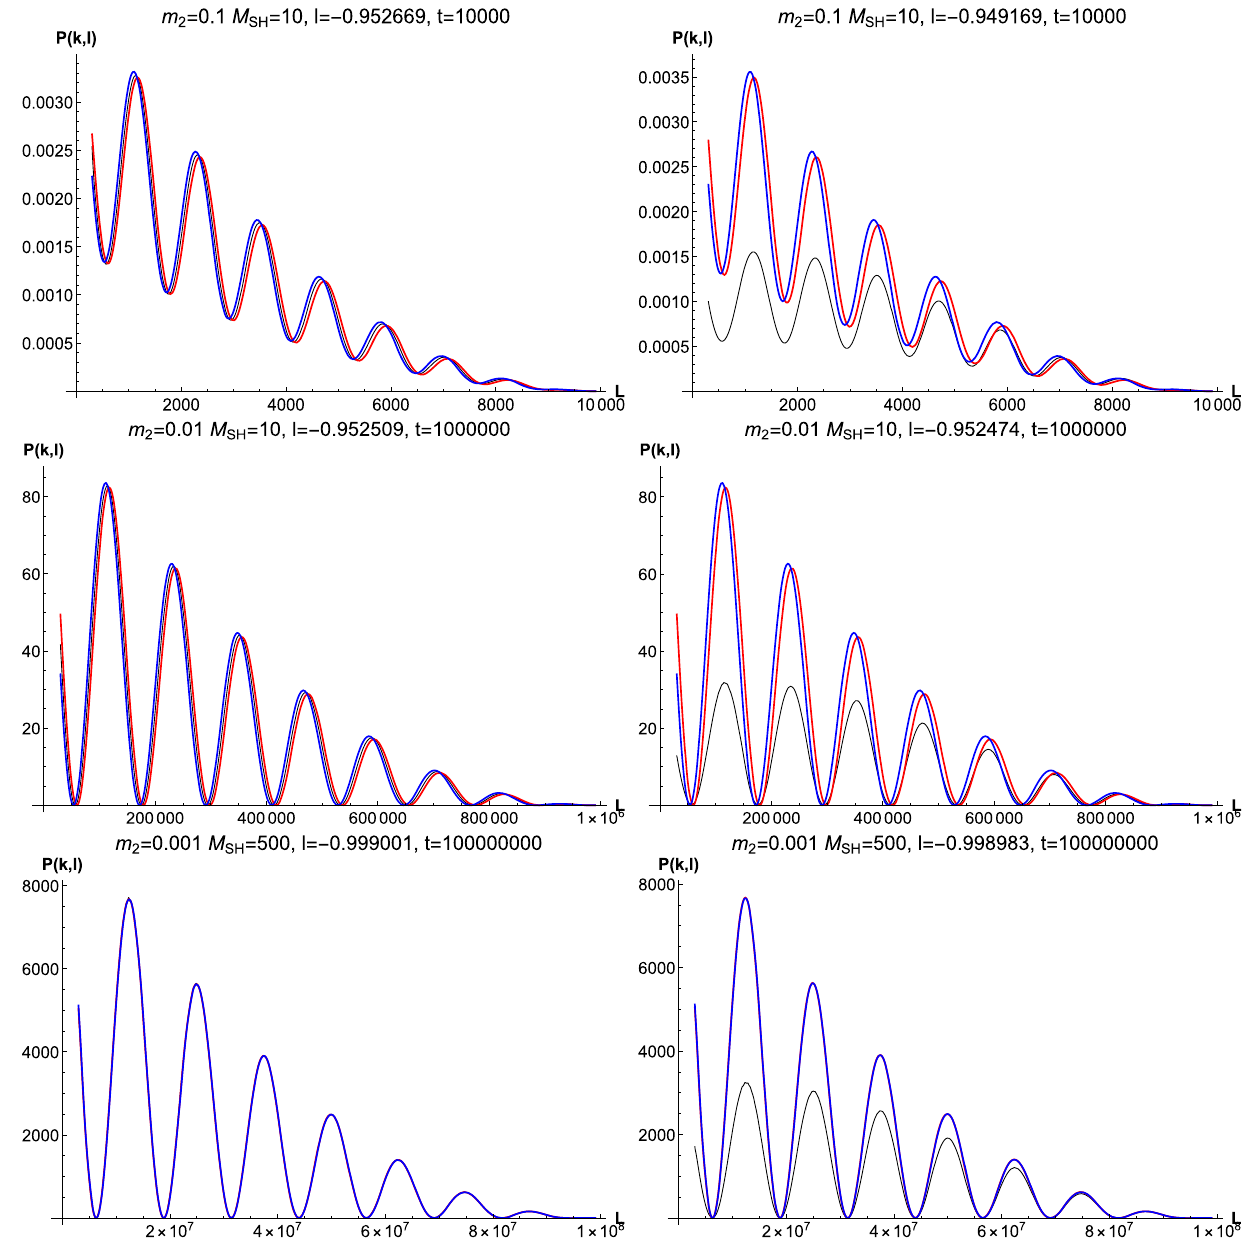
Fig. 3 P ( k , l ) as a function of L , plotted for different values of m 2 , M SH and δ l (as defined in Fig. 2). The legend for the colors is the same as in Fig. 1. For lager values of M SH , the difference between the red and blue curve is negligible. σ d = σ s = 0 . 015